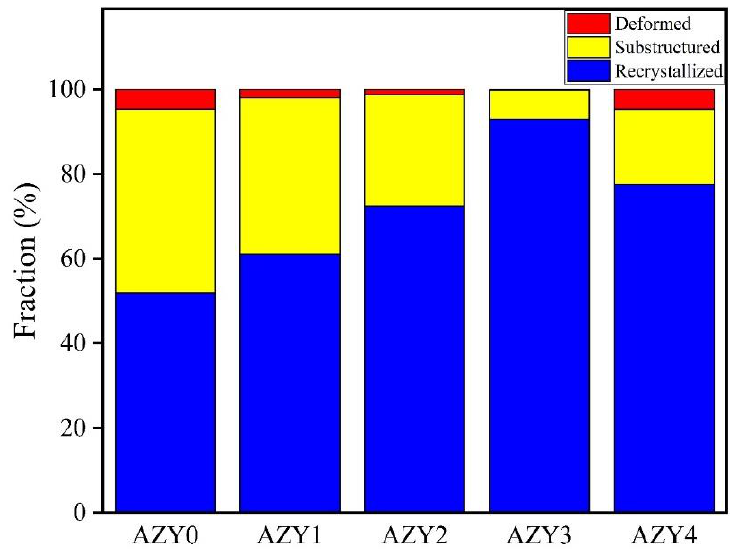
Figure 5. Statistical diagram of grain recrystallization for the rolled sheets with different Y contents.